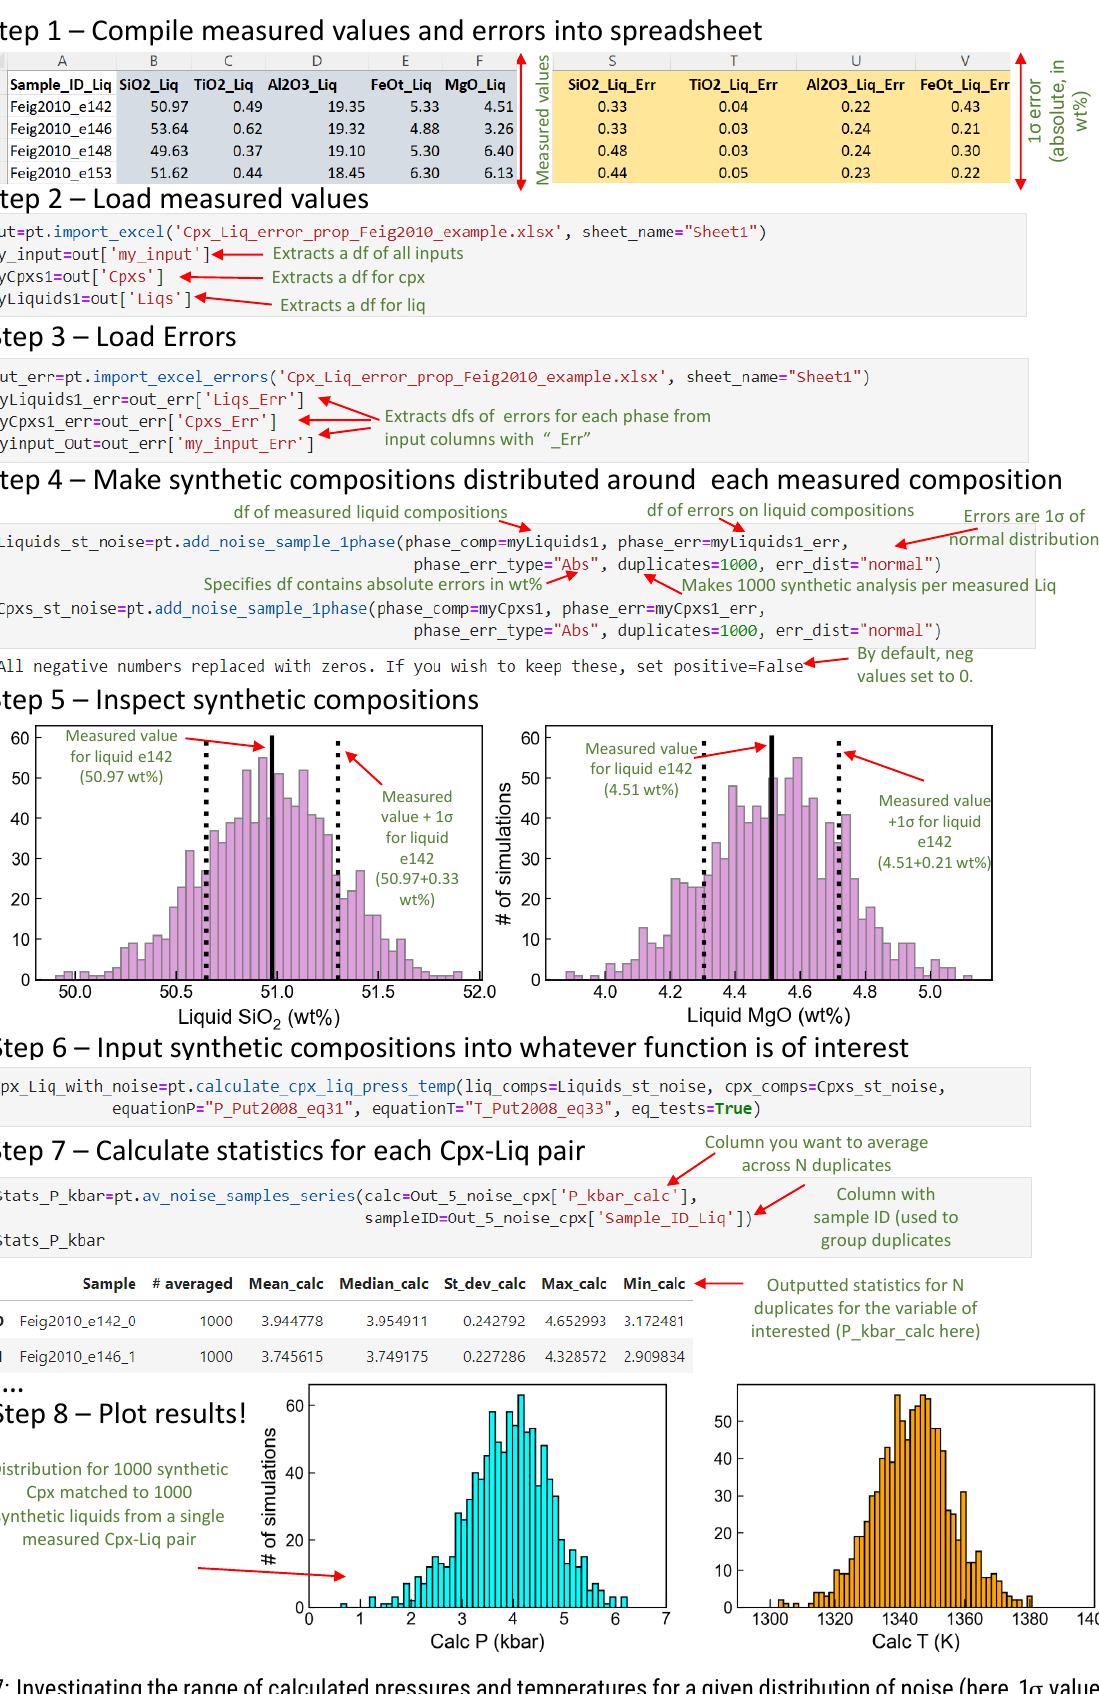
Figure 7: Investigating the range of calculated pressures and temperatures for a given distribution of noise (here, 1 σ values from repeated measurements of Cpx and Liq in the experimental study of Feig et al.